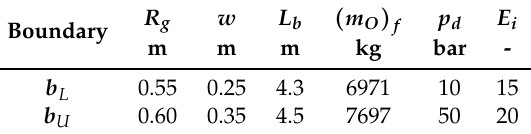
Table 3. Design parameters ranges: EPFS.